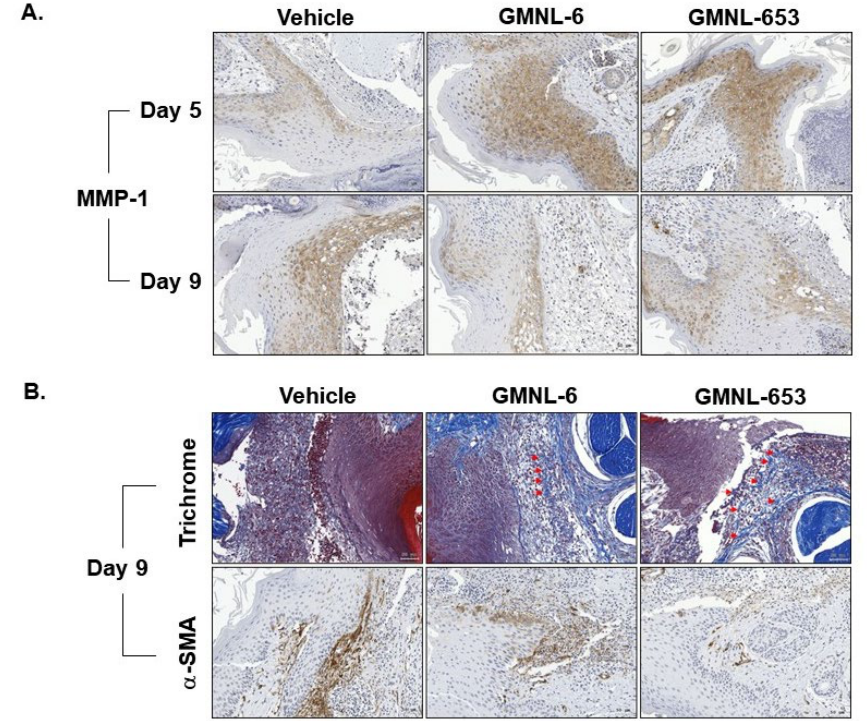
Figure 5. The treatment of heat-killed Lactobacillus GMNL-6 or GMNL-653 increases MMP-1 expression in the early stage and decreases α SMA expression at the later stage during the tail-wound healing. The experimental tail wounds were introduced as described in the Materials and Methods section and covered with gels that contained heat-killed GMNL-6 or GMNL-653 bacterial cells. The expressions of MMP-1 ( A ) or α SMA (lower panel in B ) were determined by immunohistochemistry and the collagen fibers were determined by Trichrome stain (upper panel in B ). Arrows in the upper panel of ( B ) indicated the structured collagen fibers.